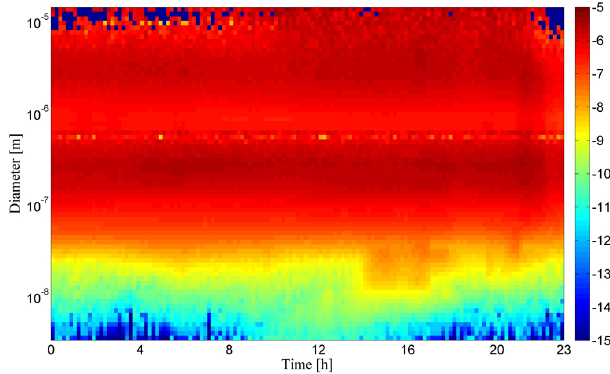
Fig. 2b. As in Fig. 2a, but for the combined state ( x V com ) .